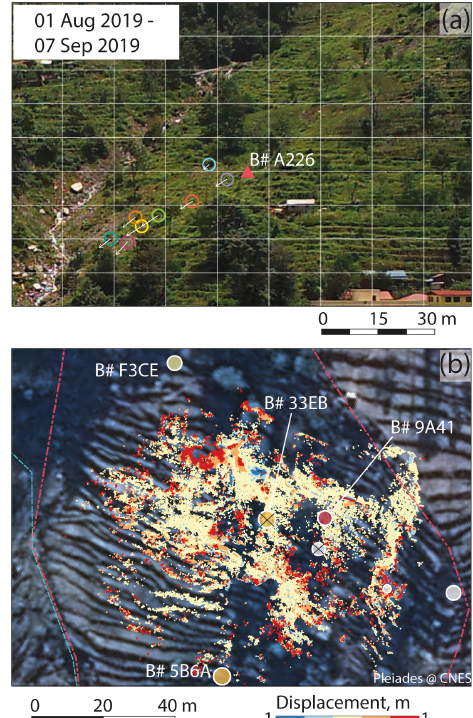
Figure 7. Examples of movements in the landslide body between panels (a) and (b) . Coloured circles visually represent traceable pix- els. Their movement is visible through the superposed grid. The approximate location of B-A226 is shown. (c) Scan data for the upper part of the landslide area show several zones of movement; red represents accumulation and blue erosion. Black crosses repre- sent boulders that were not found after the monsoon season. Image: Pleiades (CEOS Landslides Pilot).